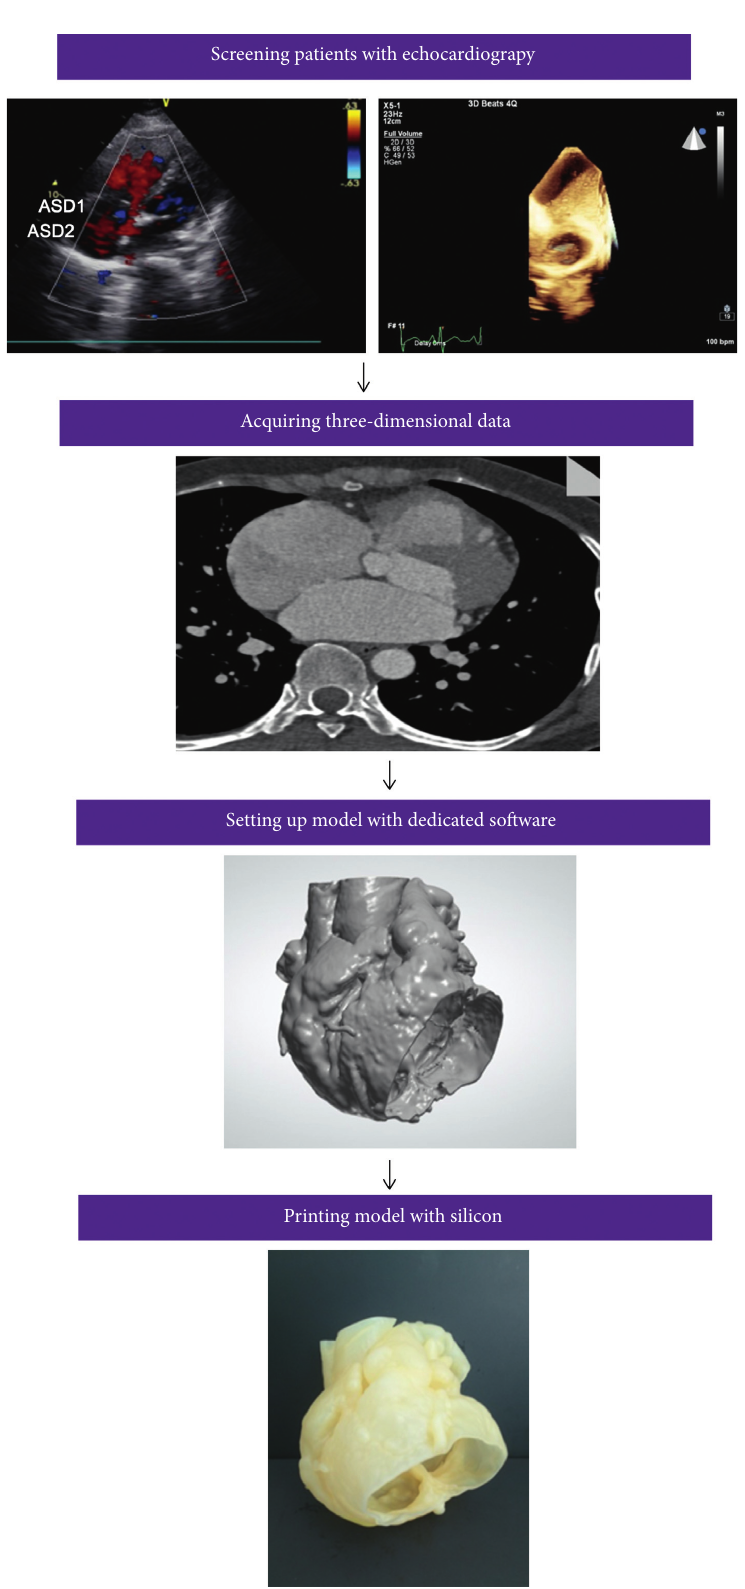
Figure 1: Three-dimensional printing working flow. Simple working flowchart in patients with multiple ASDs, from image acquisition to three-dimensional (3D) printed solid and hollow